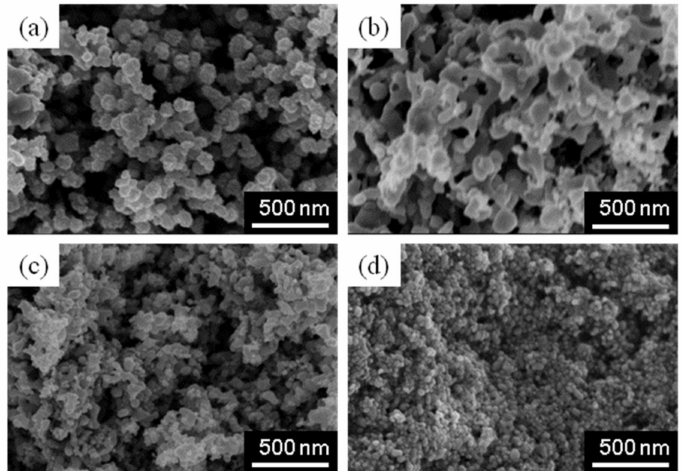
Figure 4. SEM micrographs of Cu-In alloy nanoparticles synthesized with ( a ) 2.5 mM CTAB; ( b ) 2.5 mM